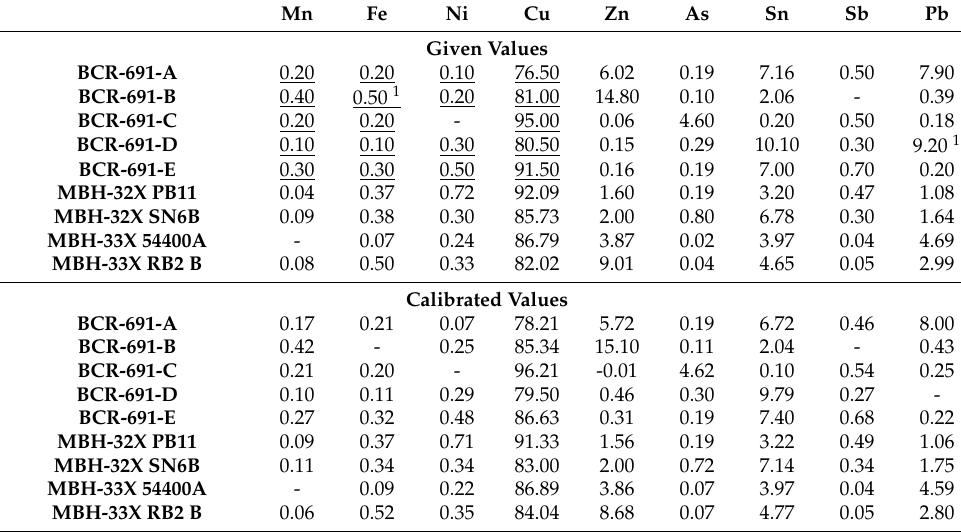
Table A1. Reference standards used for the calibration with given values (%). Uncertified values are underlined. 1 Outlier removed from